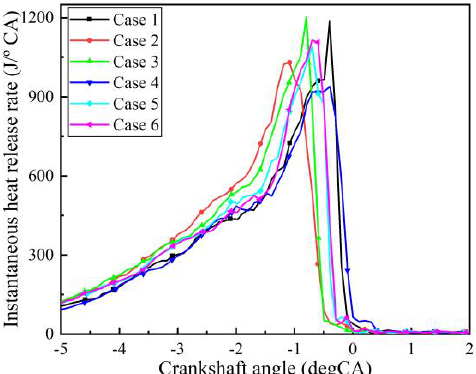
Figure 16. Mass of ( a ) CH 2 O and ( b ) H 2 O 2 radical in the cylinder in different water injection cases (CR = 10.3, ignition time = − 14 degCA).